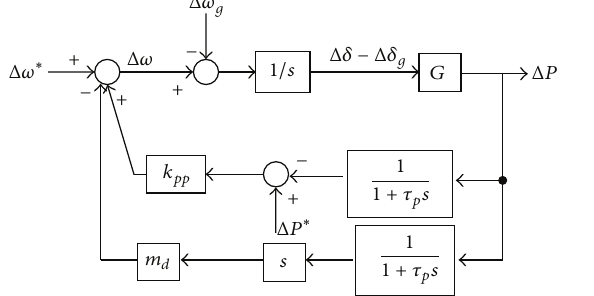
Figure 6: Small signal model of the improved 𝑄 - 𝐸 droop